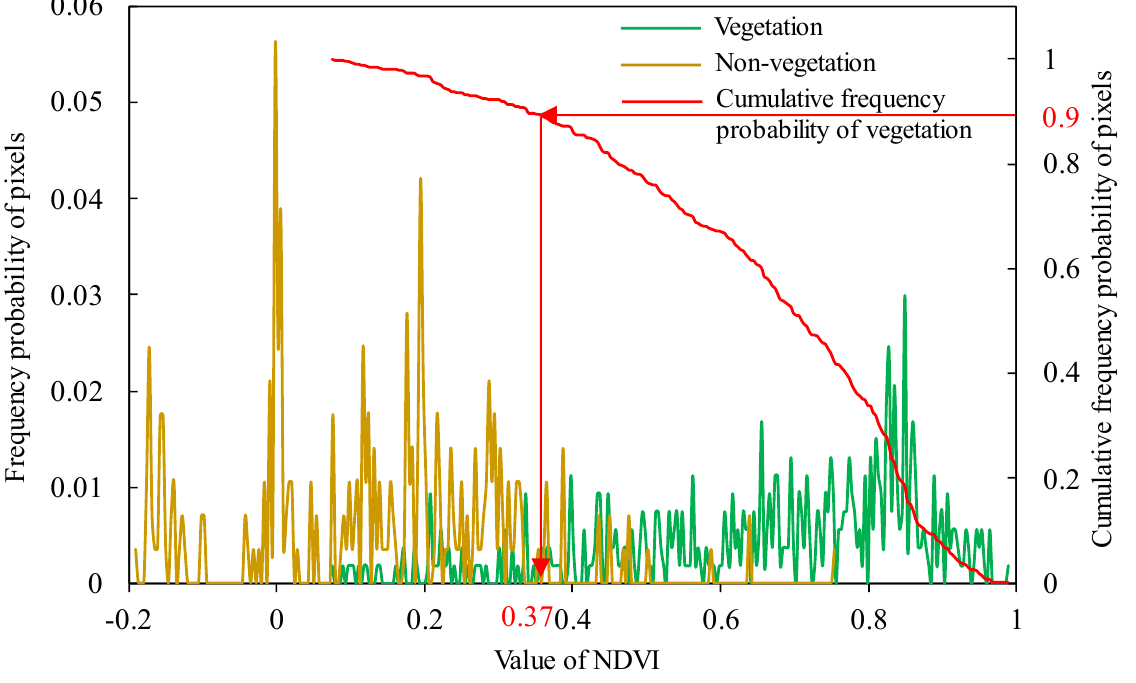
Figure A4. Pixel frequency probability distribution of NDVI values of vegetation and non-vegetation training samples.